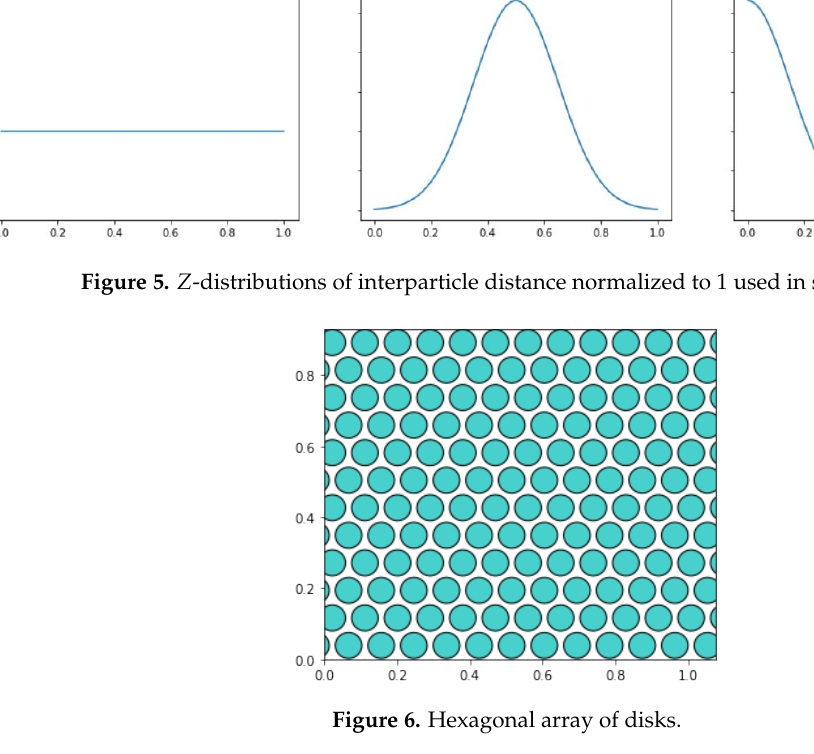
Figure 6. Hexagonal array of